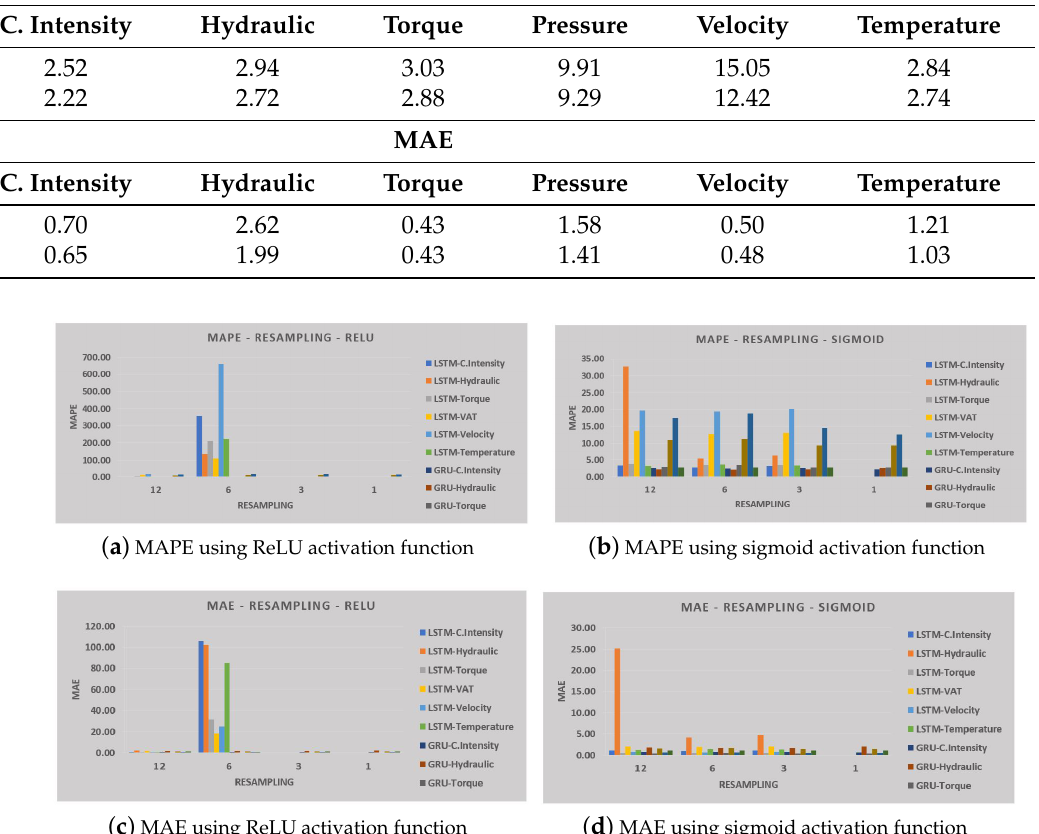
Table 4. Summary of the best prediction errors obtained with the GRU models, using different resampling rates. MAPE